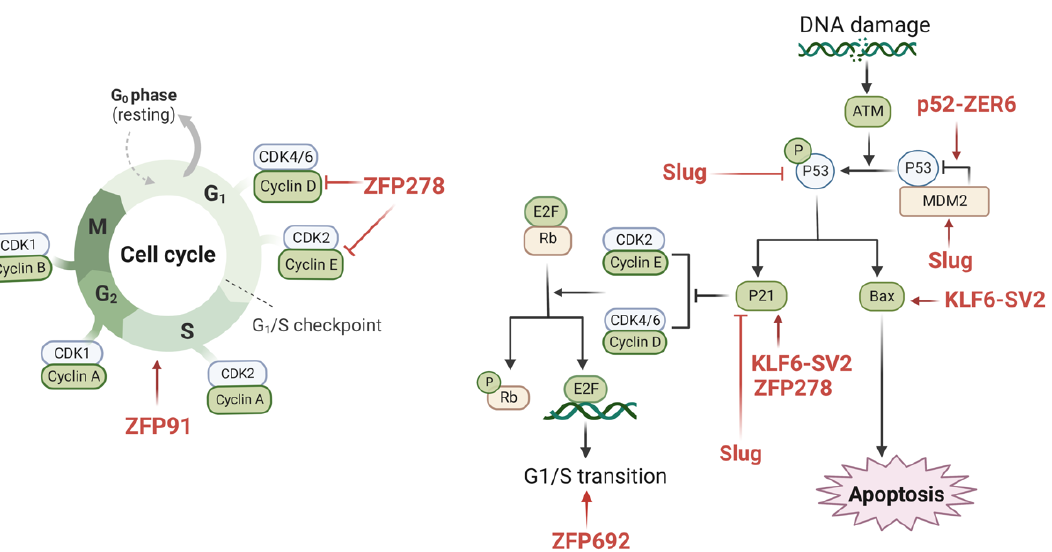
Figure 2. The possible mechanisms of ZFPs in regulating the cell cycle of colon cancer. There are various zinc finger proteins involved in cell cycle processes, such as ZFP91, ZFP278, ZFP692, Slug, KLF6-SV2, and P52-ZER6. The underlying mechanisms involve cyclin D, cyclin E, E2F, p21, p53, Bax, and MDM2. The underlying mechanism affects multiple molecules, such as cyclin D, cyclin E, E2F, p21, p53, Bax, and MDM2, eventually inducing cell progression or inhibiting cell proliferation in colon cancer. These ZFPs have great potential as novel therapeutic targets for colon cancer. (This figure was created with biorender. com.)